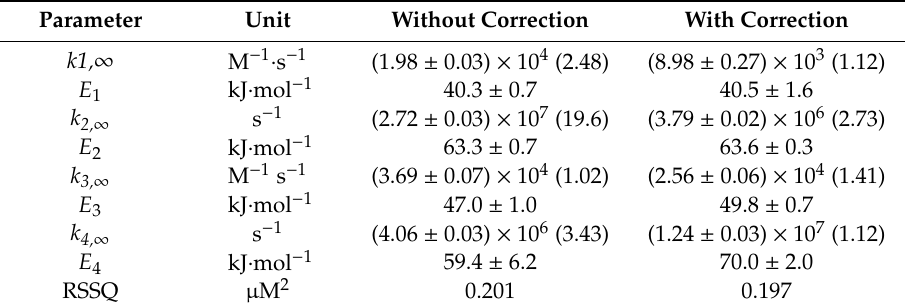
Table 5. Parameter estimates for set 4 (n-butanol as solvent). For the pre-exponential factors, the deviation is indicated between